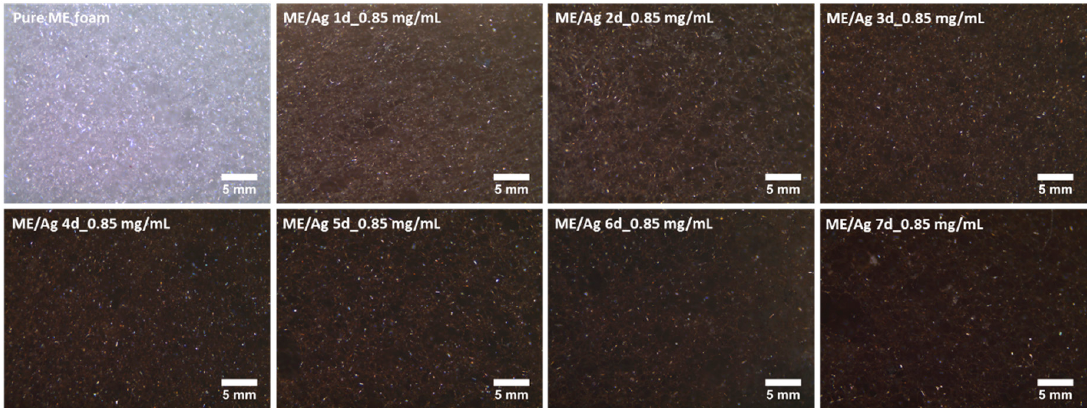
Figure 2. Optical micrographs (40×) of the untreated ME (Pure) and functionalized ME/Ag using 0.85 mg/mL as solution precursor, showing a homogeneously distributed color along the foams, darkening as the reaction time was increased.